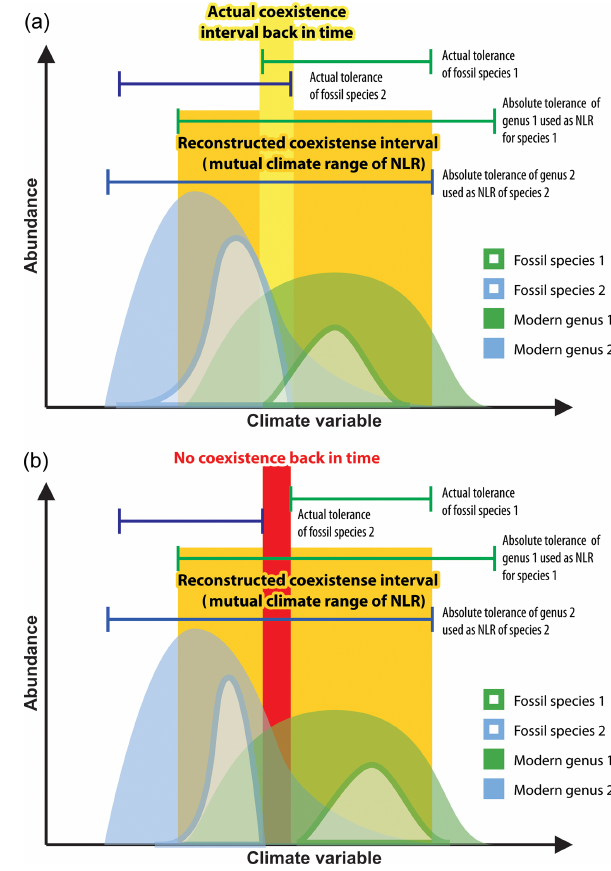
Figure 3. Issues related to the use of higher-level taxonomic classi- fication (e.g. genus or family) as nearest living relatives (NLRs) of fossil species. In this example, two fossil species occupy a climate range within the modern climate range of their selected genus-level NLRs, fulfilling the principle of physiological uniformitarianism. Panel (a) : the fossil species have a narrow shared climate range and coexisted in the past. The use of higher-level taxonomic ranks as NLRs will lead, in most cases, to a much broader and less precise reconstructed coexistence interval. Panel (b) : the fossil species are mutually exclusive, but the expansion of the niche space – due to the use of genera as NLRs – results in a coexistence interval (i.e.